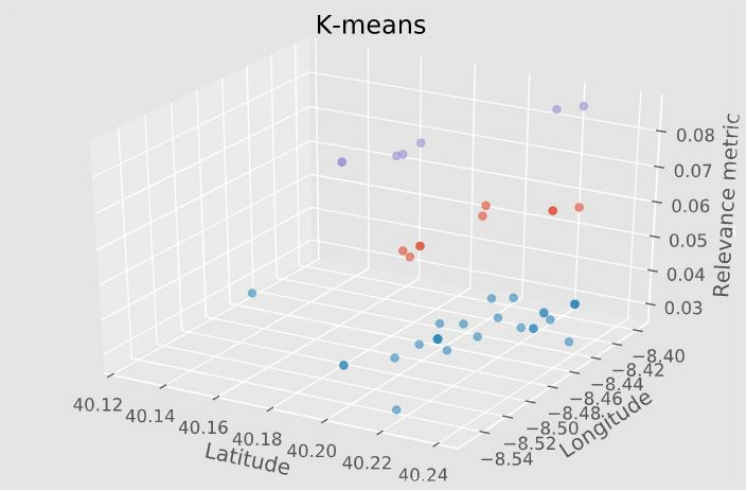
Figure 3. 3D scatter plot of the K-means clustering applied to user locations with K =